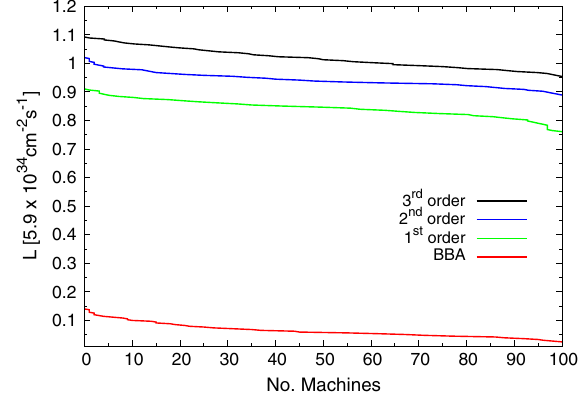
FIG. 6. Tuning results for the double beam study. Red curve shows the accumulated luminosity histogram after BBA. Green, blue and black curves represent the maximum luminosity obtained by scanning 1st, 2nd, and 3rd order knobs,